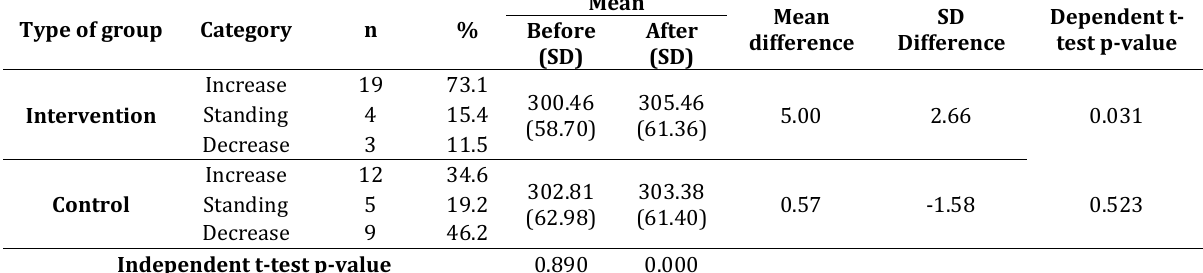
Table 2. Differences in CD4 counts between the intervention and control groups (pre- and post-test; N = 52) Type of